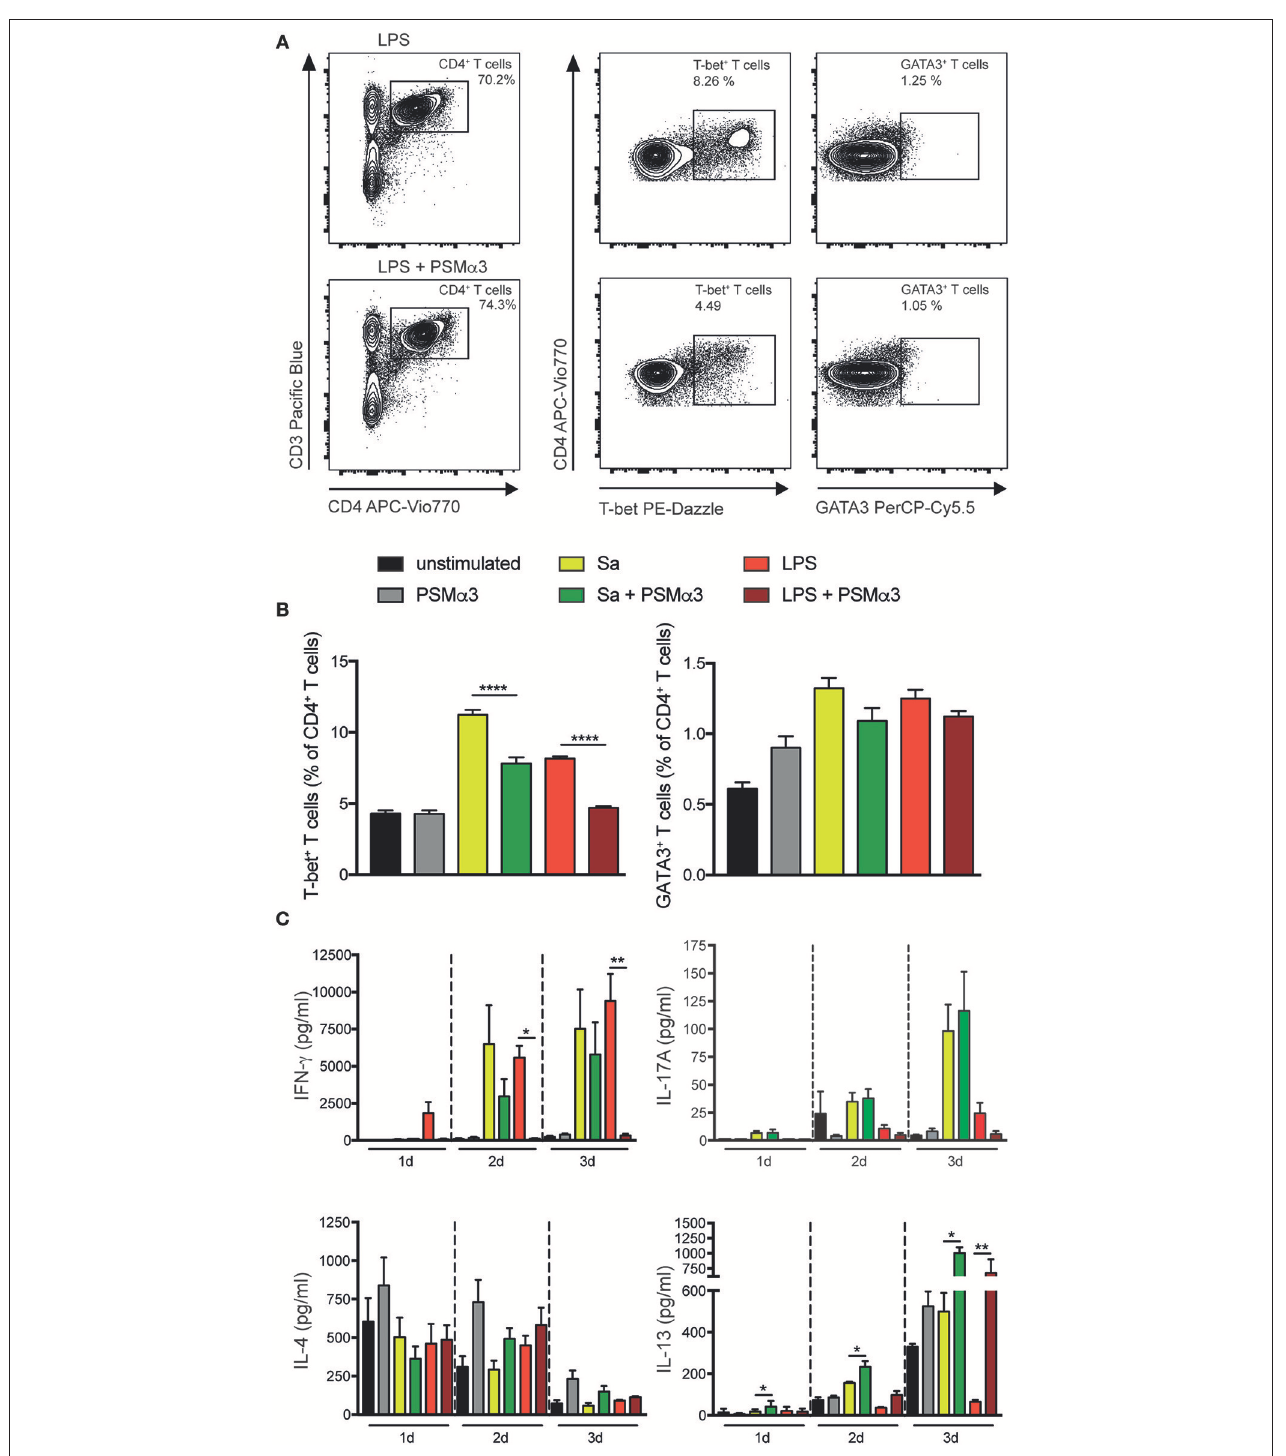
FIGURE 4 | Polarization of Th1 is impaired by PSMs. MoDCs treated for 24h with Sa lysate or LPS with or without PSM α 3 or PSM α 3 alone were co-cultured with CFSE-labeled naïve CD4 + T cells for 3 d. The different Th subsets were analyzed by flow cytometry; Th1 cells were characterized as CD3 + CD4 + T-bet + T cells, Th2 cells were characterized as CD3 + CD4 + GATA3 + T cells (A) . (B) The bar graphs show the frequency of T-bet + Th1 and GATA3 + Th2 cells from CD4 + T cells (one representative of n = 4 independent experiments performed in triplicates, mean ± SEM). (C) Cell culture supernatants from the DC T cell co-culture were collected after 1 d, 2 d or 3 d and analyzed for Th-associated cytokine production ( n ≥ 3 performed in triplicates; mean ± SEM). * p < 0.05, ** p < 0.005, or **** p < 0.0001, one-way ANOVA with Turkey’s posttest or Kruskal-Wallis with Dunn’s posttest.